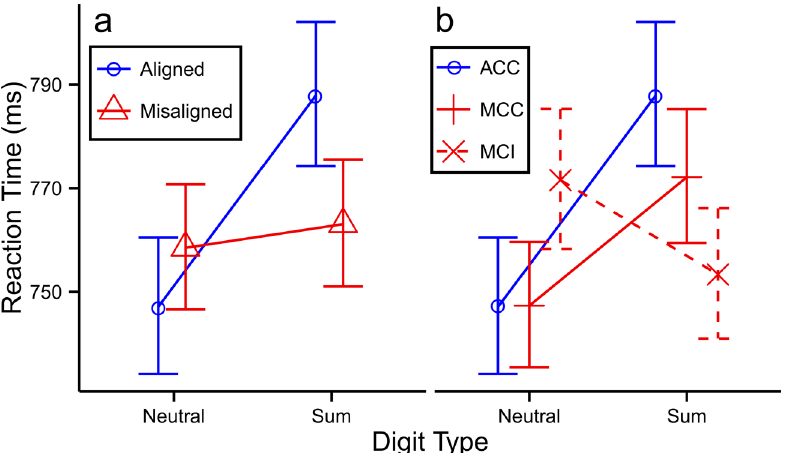
Figure 4. Reaction times in the Number Matching task (non-matching trials only) with Context for sums separated (a) two ways into Aligned Concrete-Concrete (ACC) vs. Misaligned, and (b) with Misaligned further separated into Misaligned Concrete-Concrete (MCC) and Misaligned Concrete-Intangible (MCI). Error bars represent one standard error of the mean.